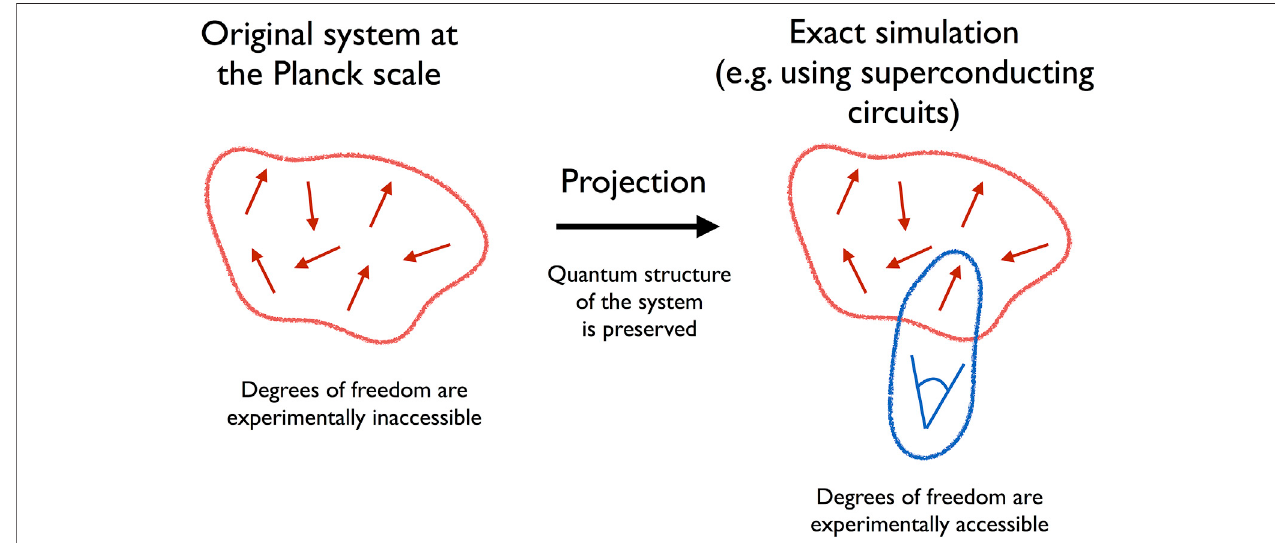
FIGURE1| Pictorial presentation oftherelation betweenthe originalquantumsystemde fi ned at the Planckscales and its exactsimulation.The exactsimulation is performedwiththeuseofprojectionoftheoriginalquantumsystemontothearchitectureofaquantumcomputer.IncontrasttothePlanckscalesystem,measurements of the quantum degrees of freedom can be performed at the level of the quantum